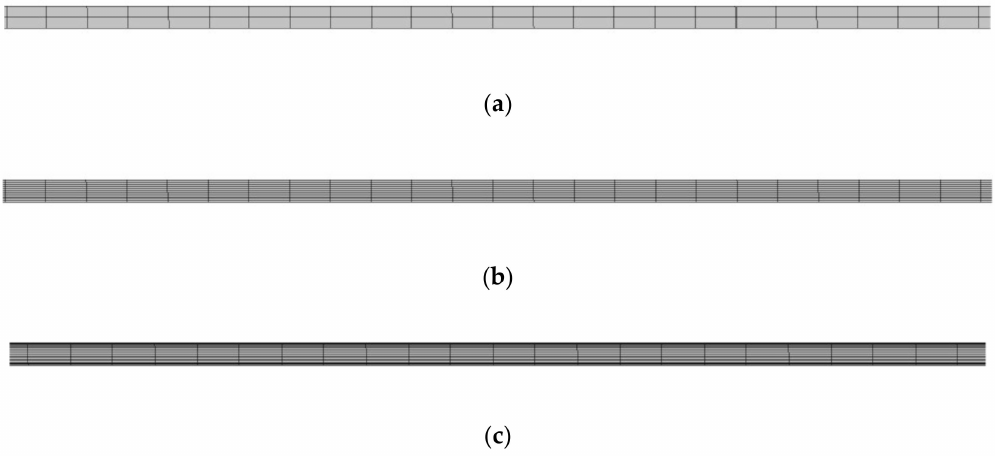
Figure 4. The distribution of different grid nodes. ( a ) 3 nodes, ( b ) 11 nodes, ( c ) 21 nodes. Figure 5 shows the velocity distribution at the clearance with different grid nodes.